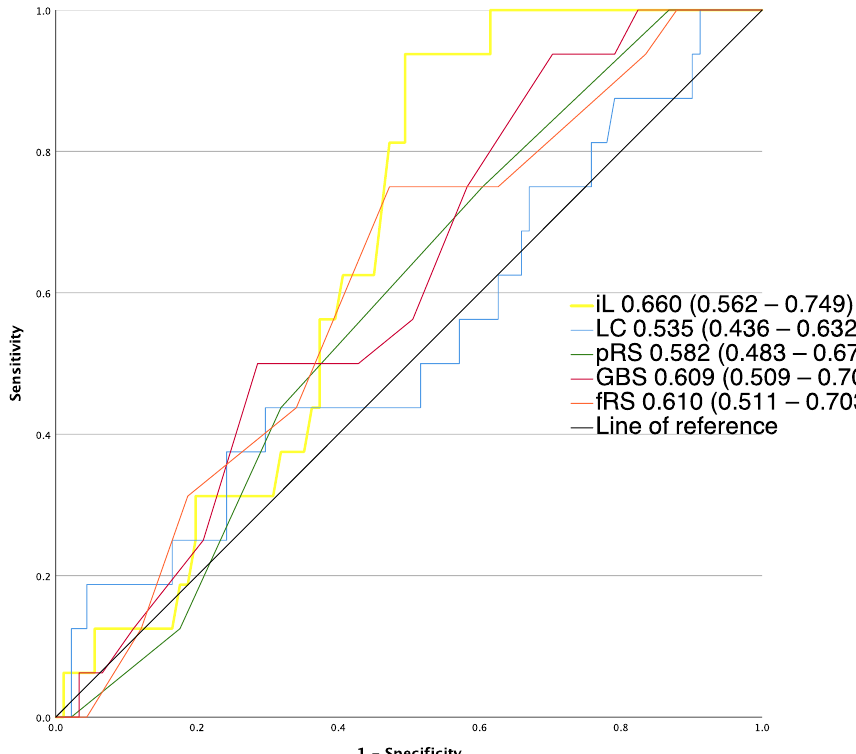
Figure 2. AUROCs of risk assessment tools for the prediction of 30-day mortality fRS, full Rockall score; GBS, Glasgow–Blatchford score; iL, initial lactate; LC, lactate clearance; p-RS, pre-endoscopic RS.